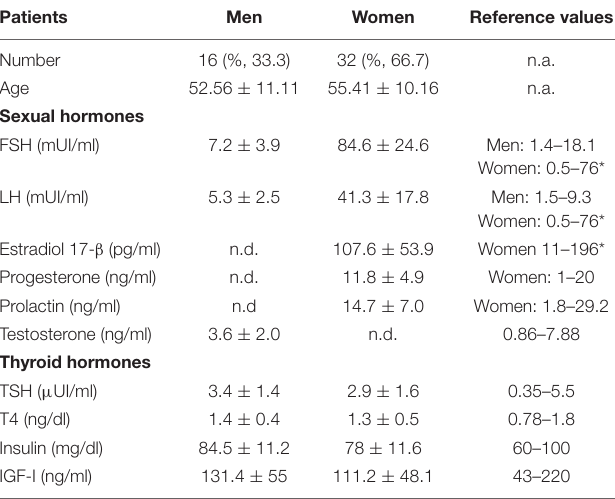
TABLE 1 | Patient’s data and hormonal values.